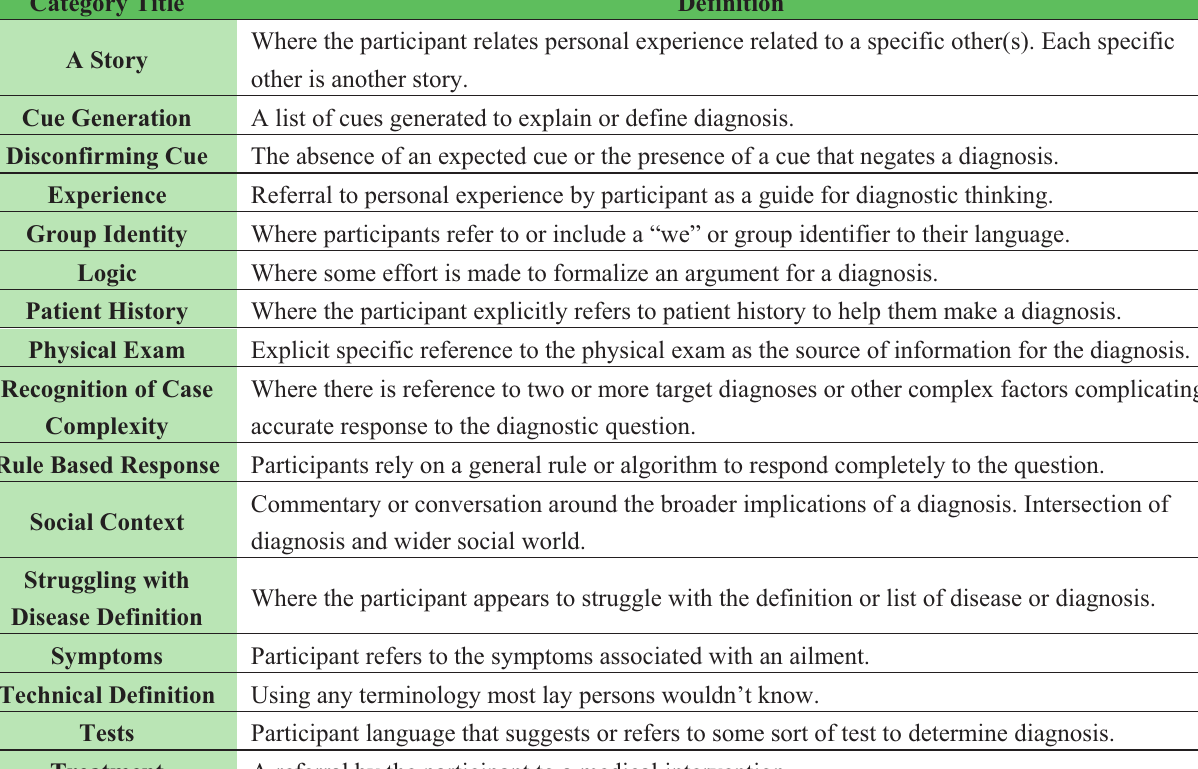
Table 2. Grounded theory categories and definitions.